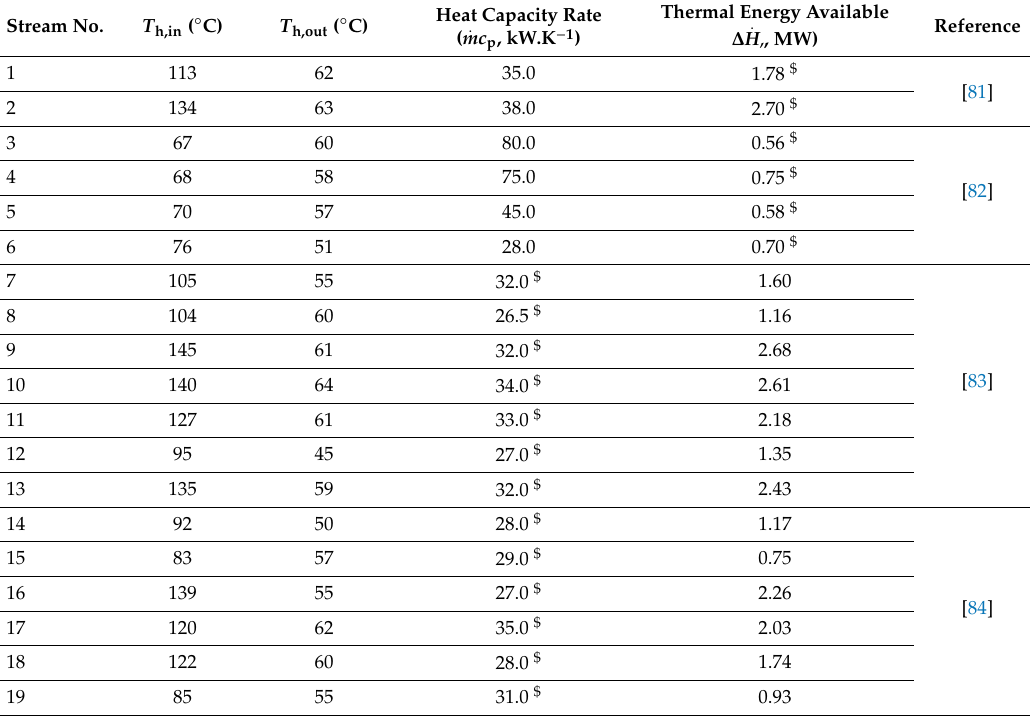
Table 5. Process data for low-grade waste-heat streams reported in various literature sources. Stream No.